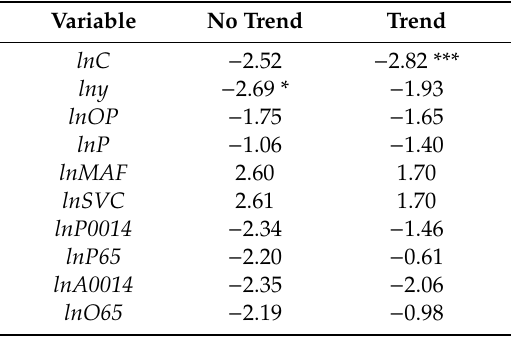
Table 4. Cross-sectionally augmented panel unit root (CIPS) test results.